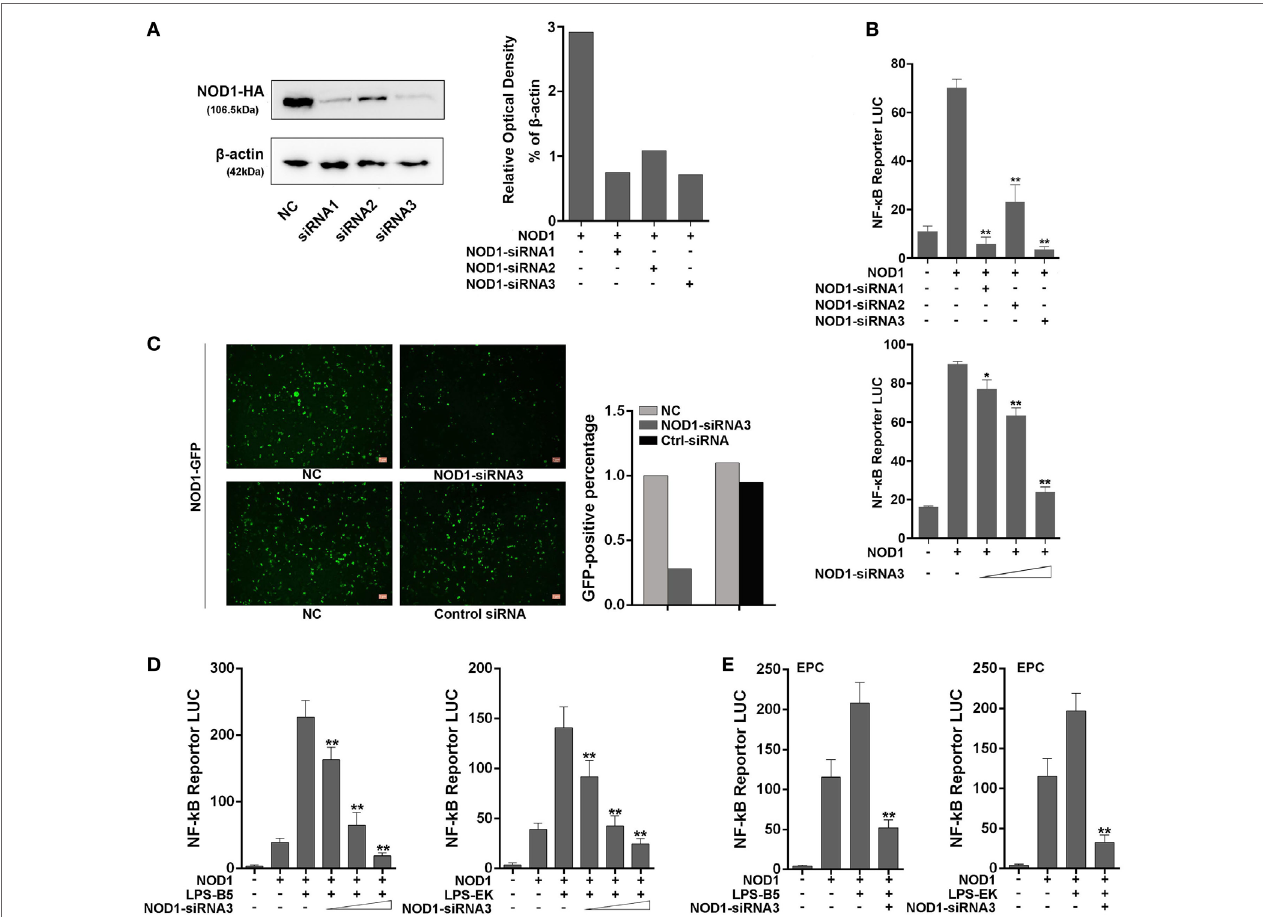
FigUre 6 | NOD1-siRNA inhibits the role of NOD1 in recognizing lipopolysaccharide (LPS). (a) Miiuy croaker NOD1 expression plasmid was co-transfected into HEK293 cells along with three NOD1-siRNA or control siRNA, respectively, after 48 h of transfection, the cells were collected to perform western blotting analysis and the relative optical density value assay were performed according to the western blotting analysis results. A cropped NOD1 and β -actin blot are shown. For un-cropped NOD1 and β -actin blot, see Figure S4 in Supplementary Material. (B) HEK293 cells were co-transfected with NOD1 expression plasmid and NF- κ B reporter plasmid along with three NOD1-siRNA, then the luciferase activity was detected. Next, co-transfection of NOD1 expression plasmid and NF- κ B reporter plasmid along with different quantity of NOD1-siRNA3 to perform a concentration gradient experiment. (c) HEK293 cells were co-transfected with miiuy croaker NOD1-GFP plasmid and NOD1-siRNA3 or control siRNA to detect the fluorescence quantity. (D) Co-transfection of NOD1 expression plasmid and NF- κ B reporter plasmid along with NOD1-siRNA3 into HEK293 cells, then stimulate the cells with LPS-B5 and LPS-EK to perform concentration gradient experiment. (e) Co-transfection of NOD1 expression plasmid and NF- κ B reporter plasmid along with NOD1-siRNA3 into EPC cells, then stimulate the cells with LPS-B5 and LPS-EK to perform dual-luciferase reporter gene assay. The pRL-TK plasmid was used as the internal control, and data are expressed as mean ± SE. The statistically significant differences were indicated by asterisks (* P < 0.05 and ** P <